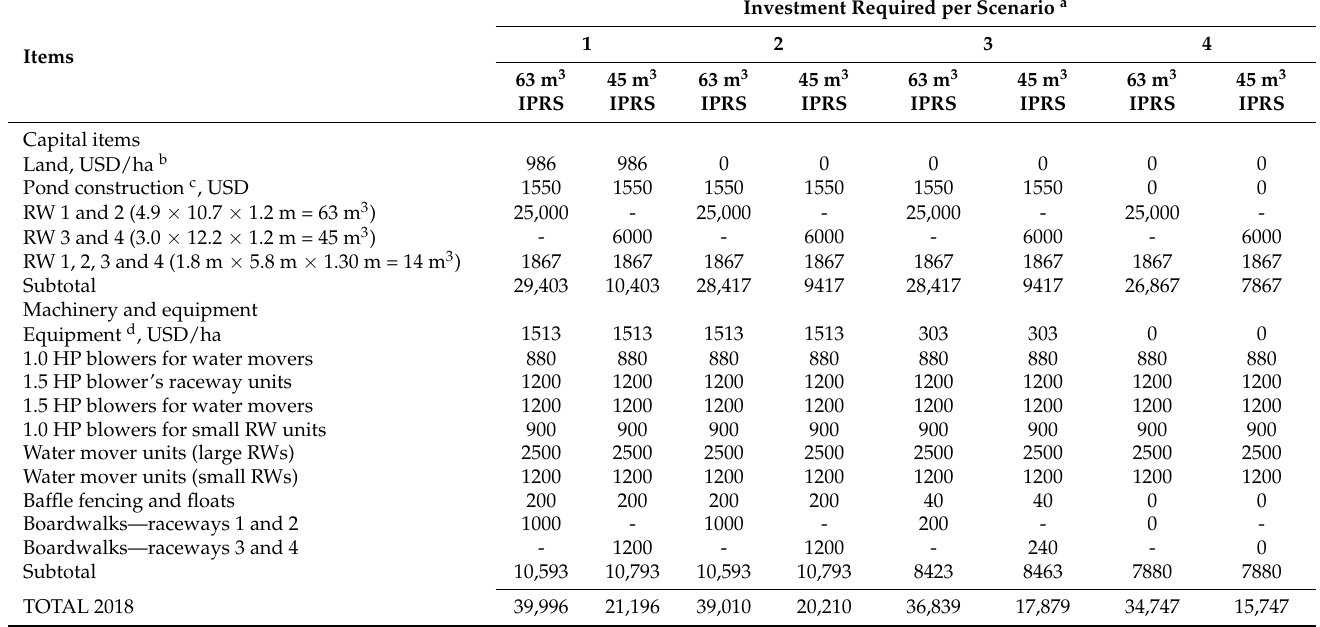
Table 11. Different levels of investment required for growout (63 m 3 or 45 m 3 ) plus stocker unit (14 m 3 ) in-pond raceway system (IPRS) scenario sensitivity analyses for each raceway placed in a 0.4 ha pond, USD,